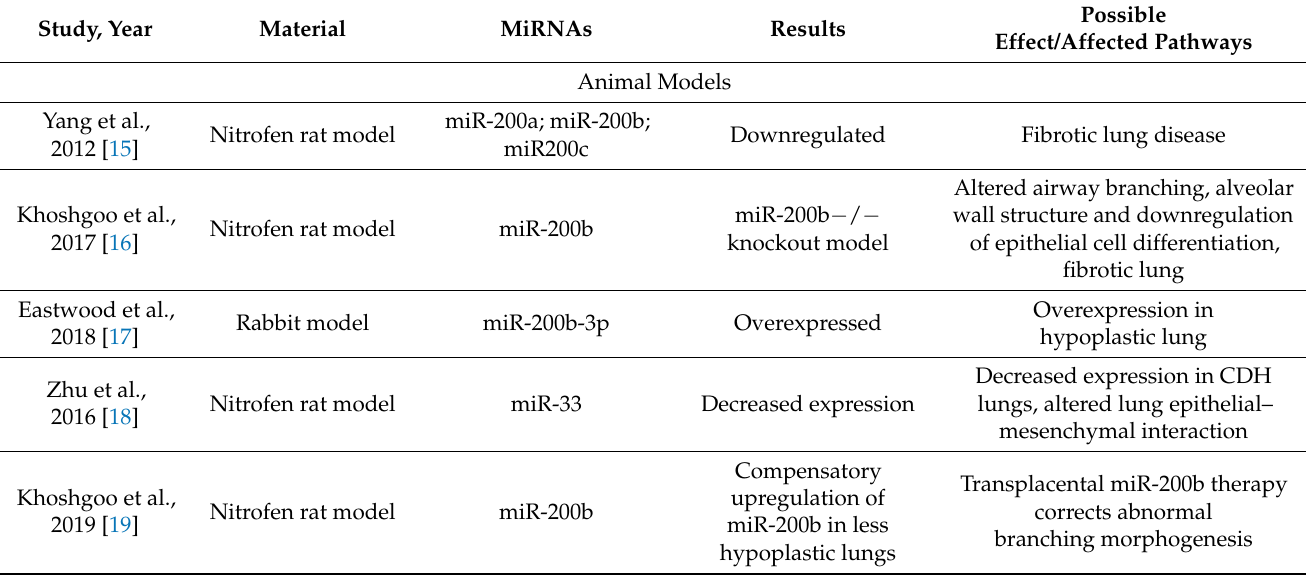
Table 1. Summary of current investigations on miRNA in CDH animal models and pulmonary hypertension and